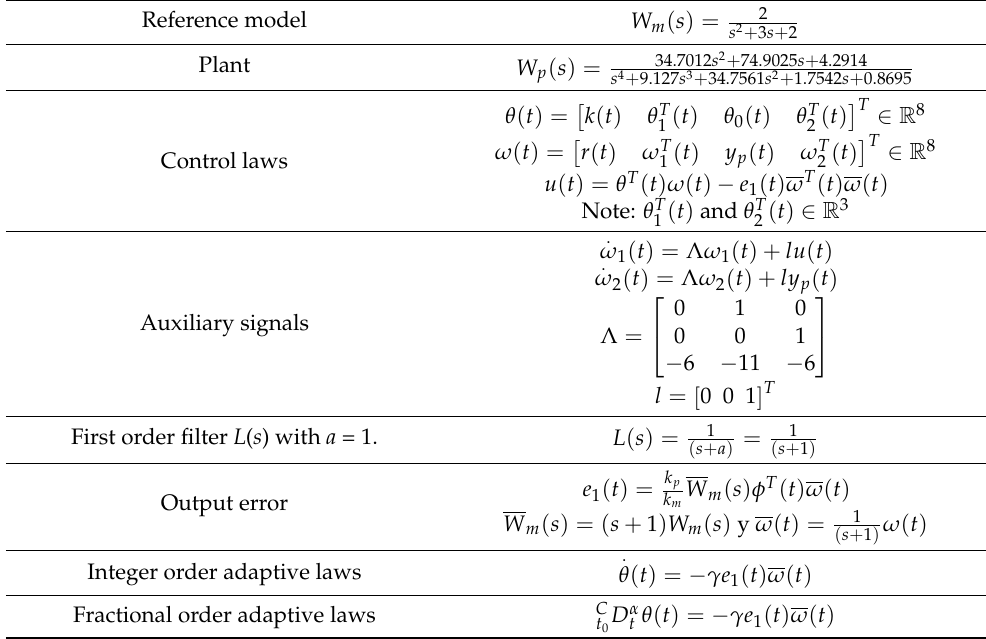
Table 4. Implementation of the IO-DMRACs and